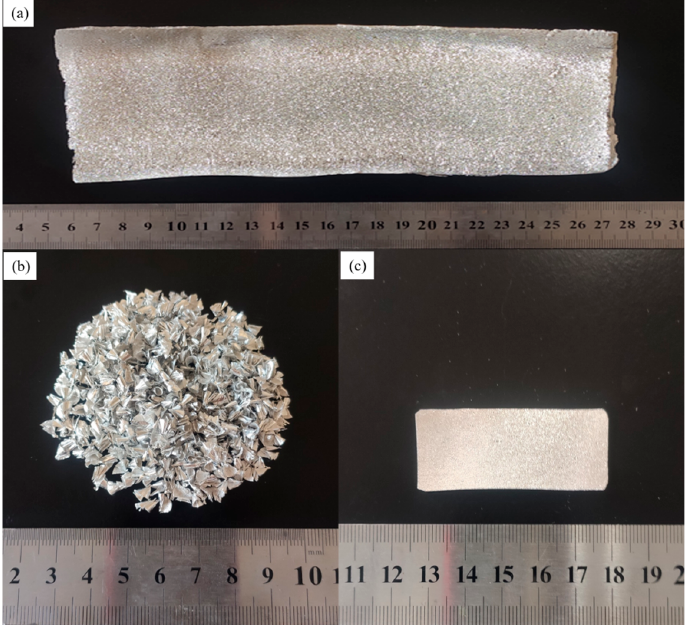
Figure 2. Photographs of ( a ) the electrolytically produced CM product, ( b ) the Mg scrap, and ( c ) the Mg block.